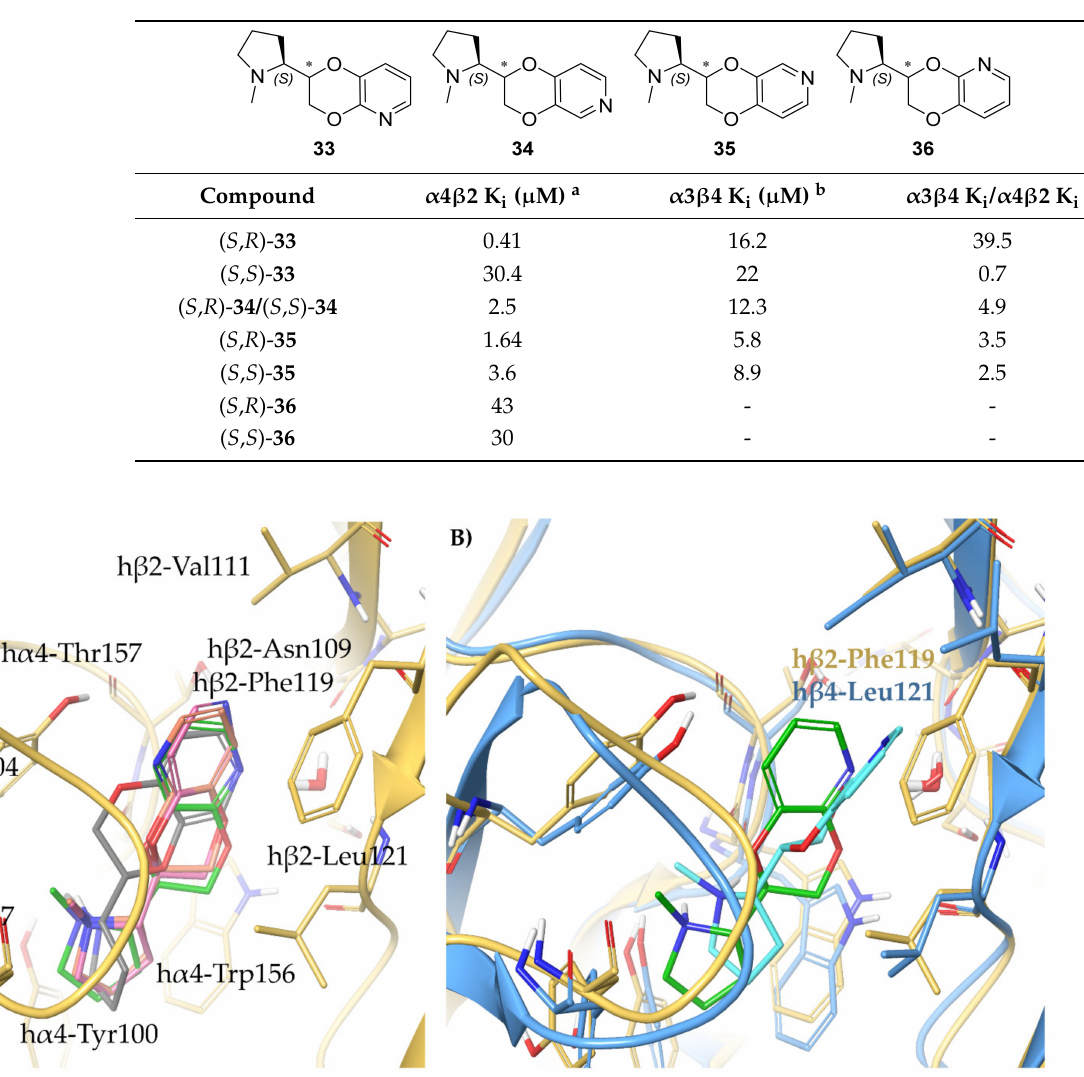
Table 5. Binding affinity data at α 4 β 2 and α 3 β 4 nAChRs and α 4 β 2 vs. α 3 β 4 selectivity ratio of compounds 33 – 36 , from Bolchi et al. [5]. a Tested at rat cortex using [ 3 H]-epibatidine. b Tested at membranes of human α 3 β 4 transfected cells.